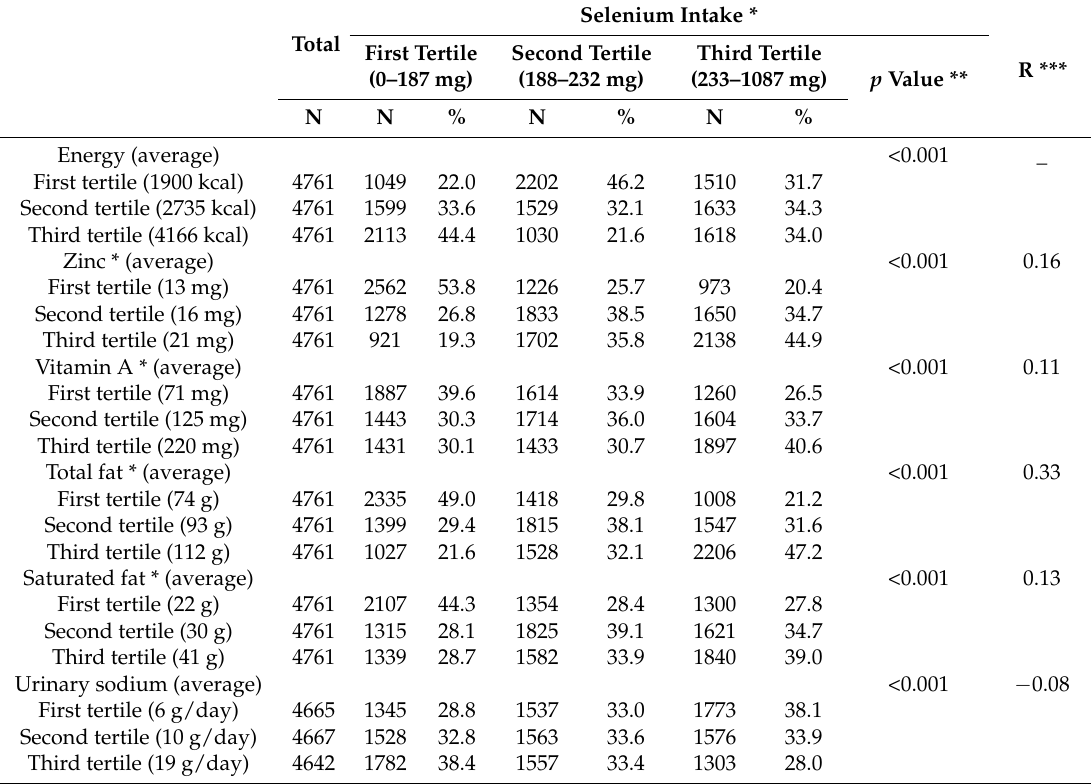
Table 2. Intake of energy and micronutrients and urinary sodium per selenium intake tertile in the ELSA-Brasil study, 2017.